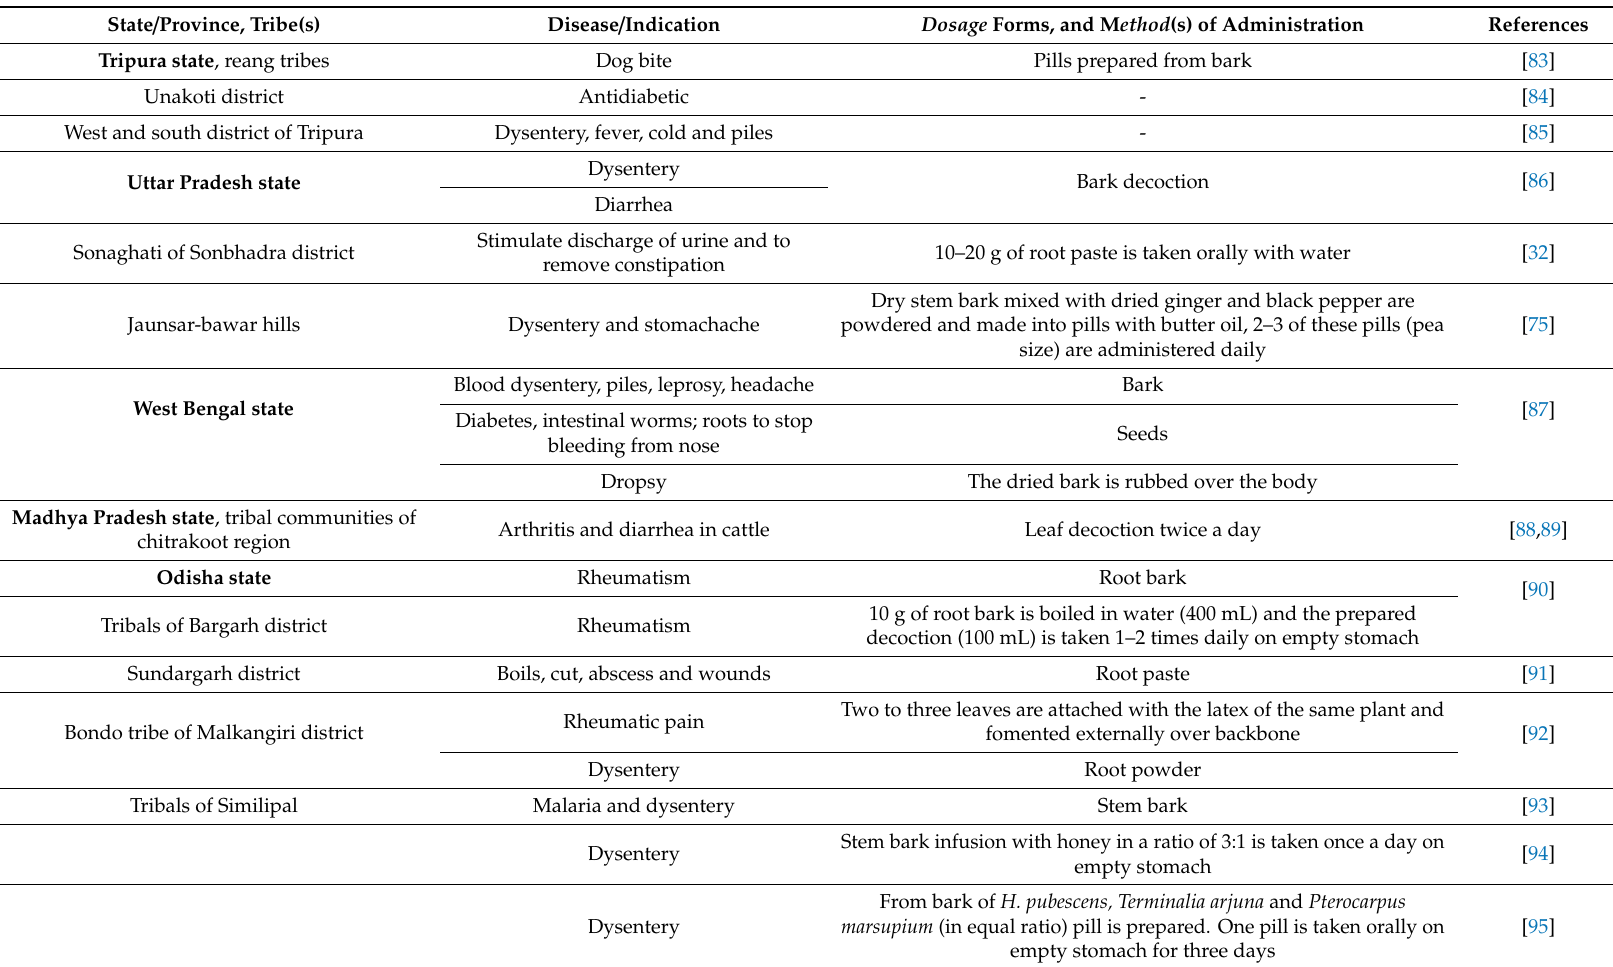
Table 3. Regional uses of H. pubescens by traditional healers across